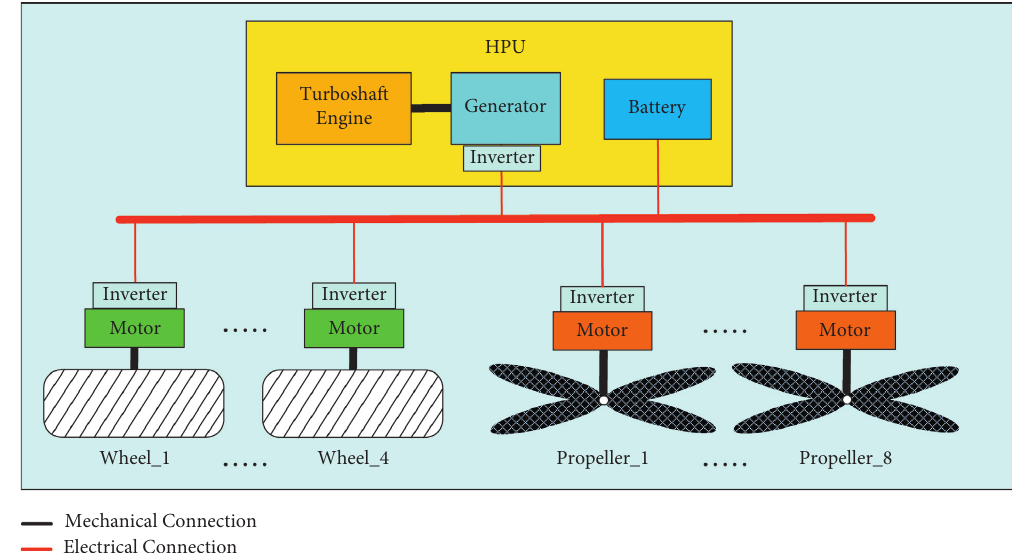
Figure 1: Description of the land and air vehicle with HPU.